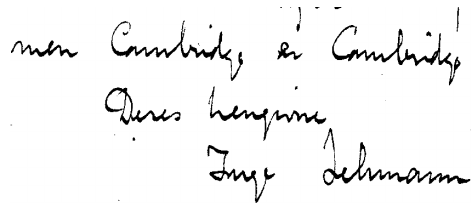
Figure 3. Inge Lehmann’s resigned note about the archaic idiosyn- crasy of Cambridge (Niels Bohr